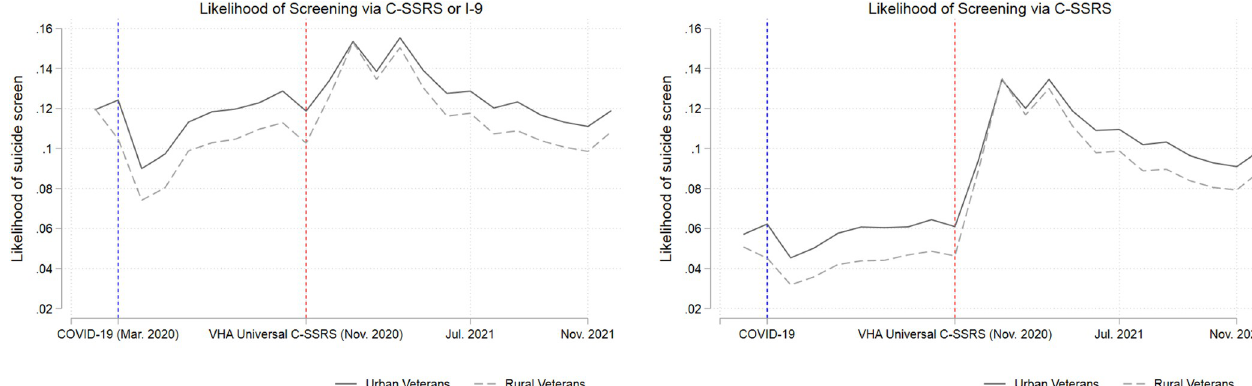
Fig 1. Unadjusted trends in the monthly likelihood of a suicide screen.